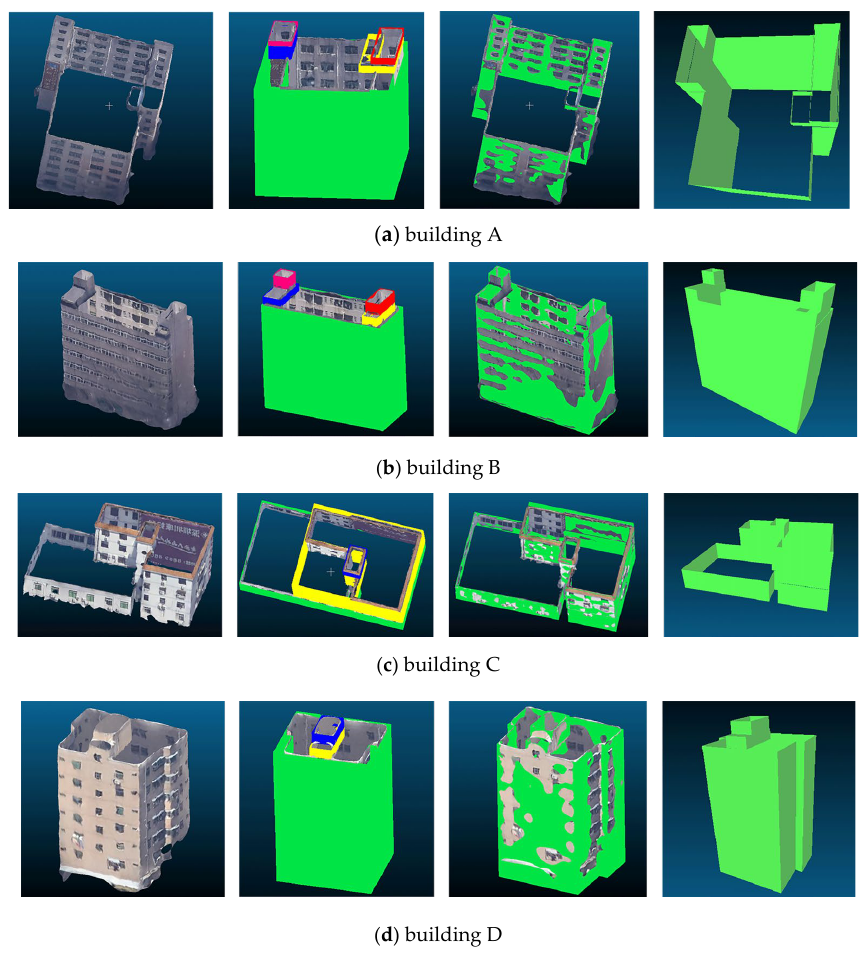
Figure 8. The reconstruction results. Each row (from left to right) presents the original photogram- metric mesh model, initial cuboid abstraction set, façade model overlaid on the original date, and 3D building façade model. building façade